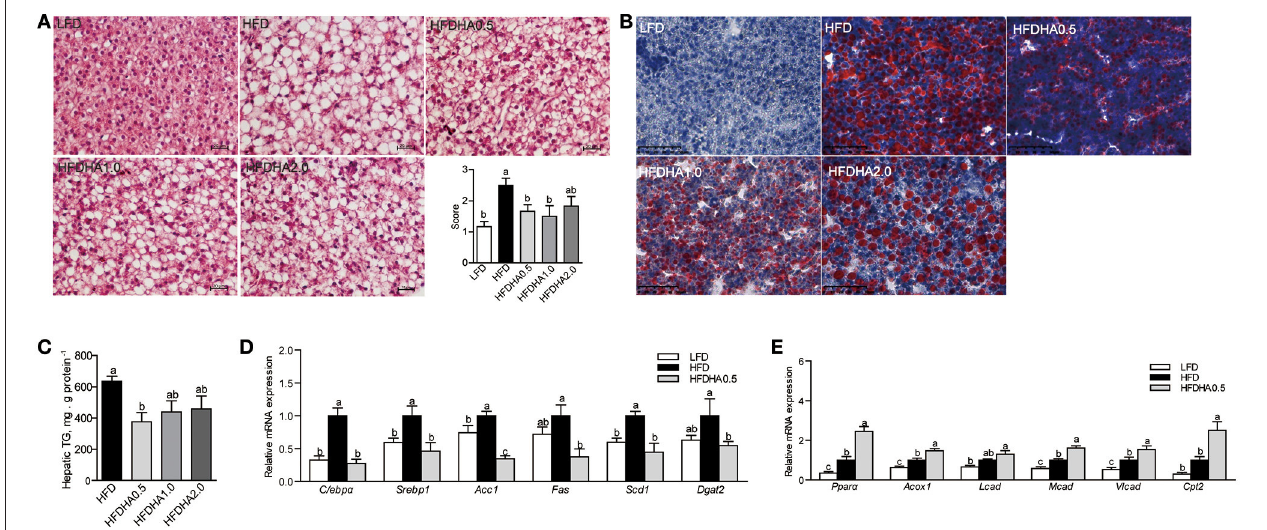
FIGURE 2 | Effects of DHA supplementation on hepatic lipid metabolism. (A) H&E staining of liver sections of LFD, HFD, and HFDHAs-fed zebrafish for 2 wks. The scale bar is 20 µ m. (B) Oil red staining of liver sections of LFD, HFD, and HFDHAs-fed zebrafish for 2 wks. The scale bar is 50 µ m. (C) Hepatic TG content of zebrafish fed HFD and HFDHAs for 2 wks. Relative mRNA expression of genes related to (D) lipid synthesis and (E) β -oxidation. Values are means ± SEMs ( n = 3-5 biological replicates). Means without a common letter are significantly different, P < 0.05.